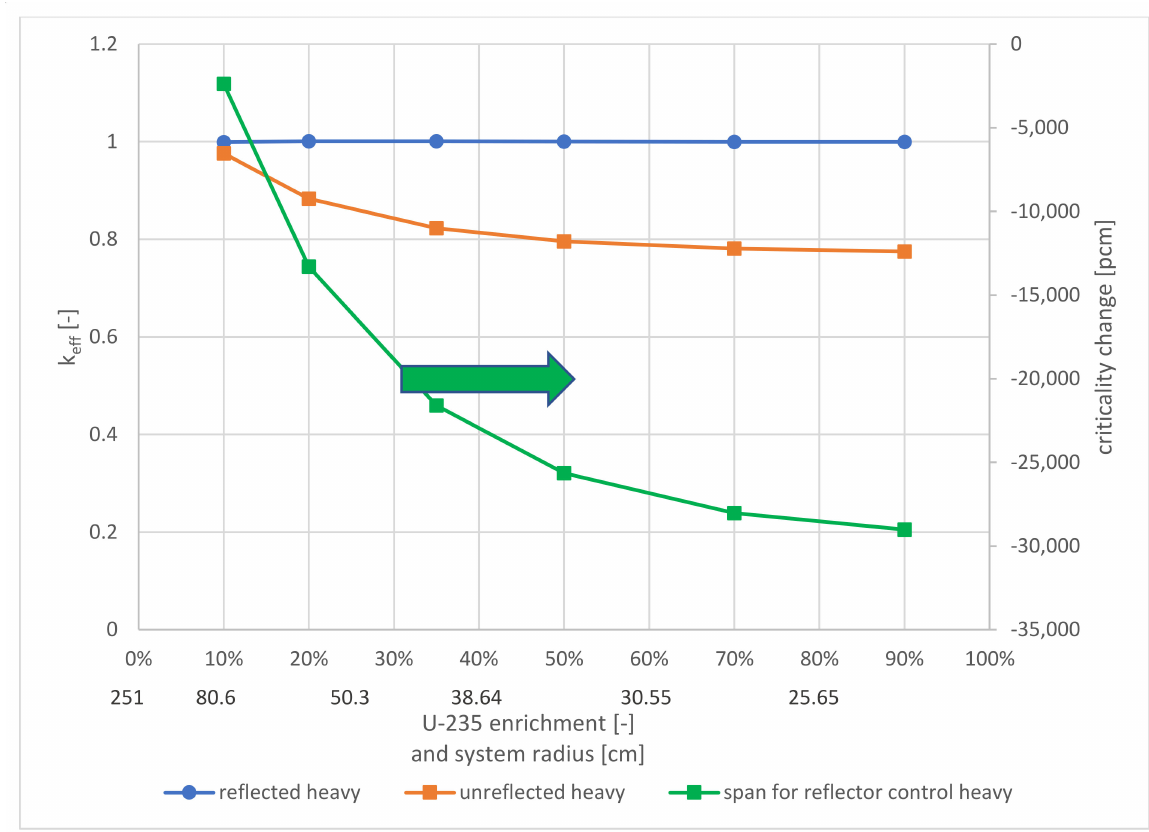
Figure 8. Criticality versus U-235 enrichment for the reflected and the unreflected 2D system demonstrating the increase in the control potential span with increasing U-235 enrichment (%). The correlated system radius required for the critical system is provided below the enrichment as further